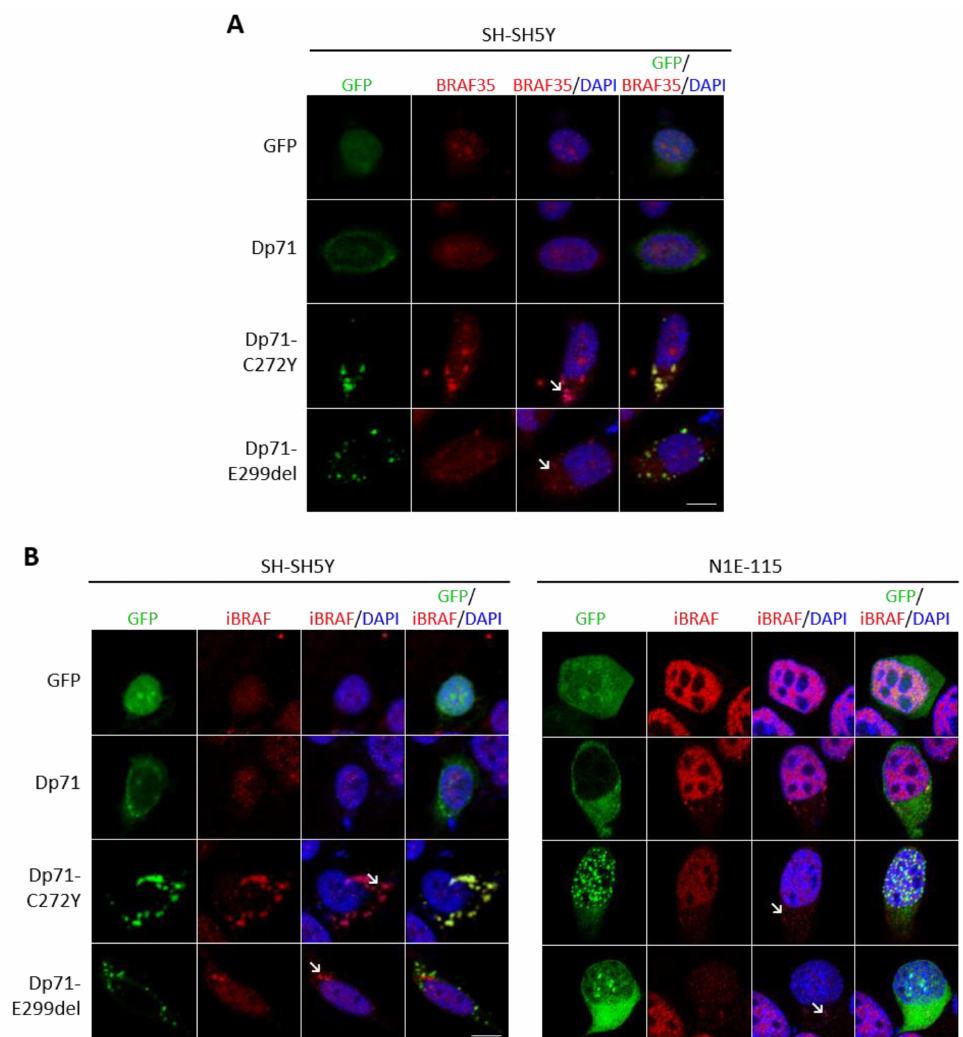
Figure 8. Cells expressing Dp71-C272Y or Dp71-E299del exhibit the altered localization of Braf35 and iBRAF. ( A ) SH-SY5Y cells transiently expressing GFP, GFP-Dp71, Dp71-C272Y or Dp71-E299del were immunostained for BRAF35 and counterstained with DAPI to visualize nuclei. ( B ) SH-SY5Y and N1E- 115 cells transiently expressing GFP, GFP-Dp71, Dp71-C272Y or Dp71-E299del were immunostained for iBRAF and counterstained with DAPI to observe nuclei. Cells were imaged by CLSM, and representative single optical Z-sections are shown (scale bar = 10 µ m). Cytoplasmic mislocalized BRAF35 or iBRAF is denoted by